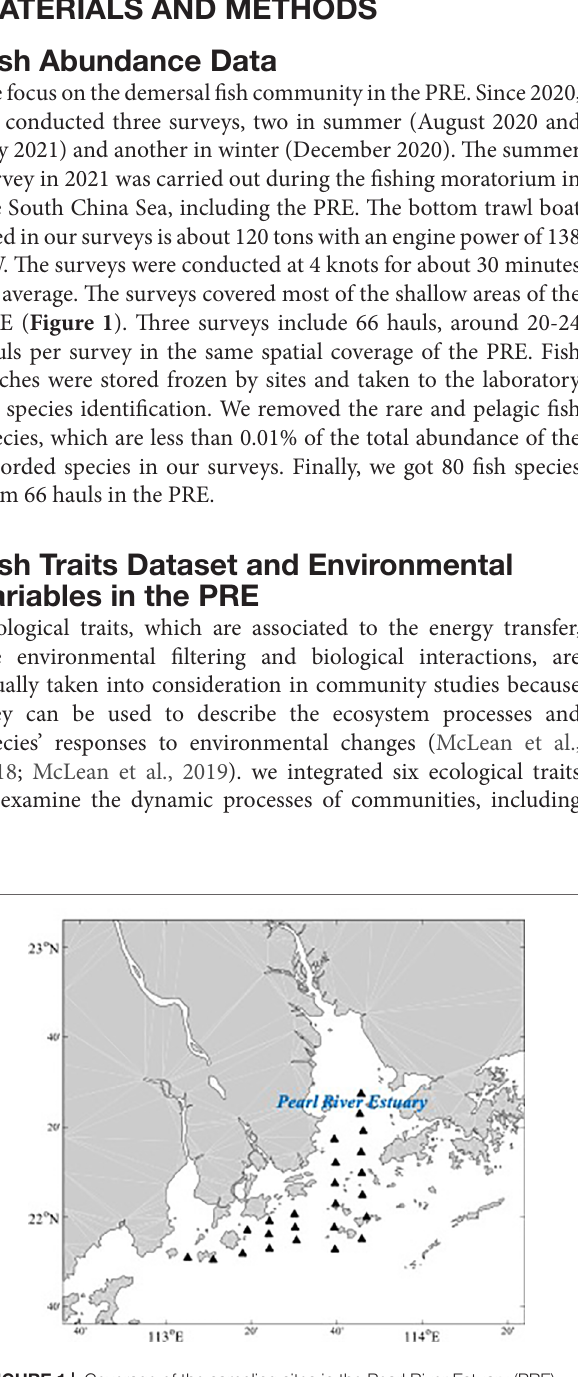
FIGURE 1 | Coverage of the sampling sites in the Pearl River Estuary